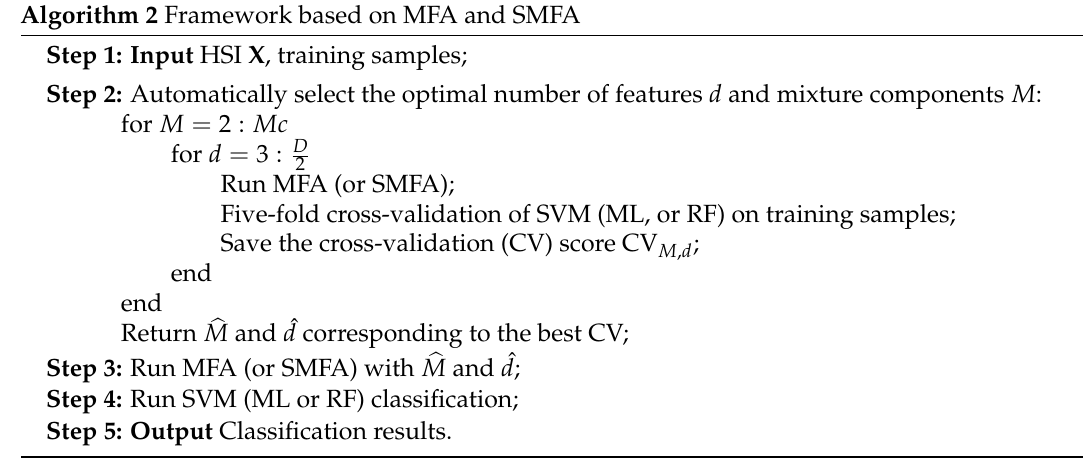
Algorithm 2 Framework based on MFA and